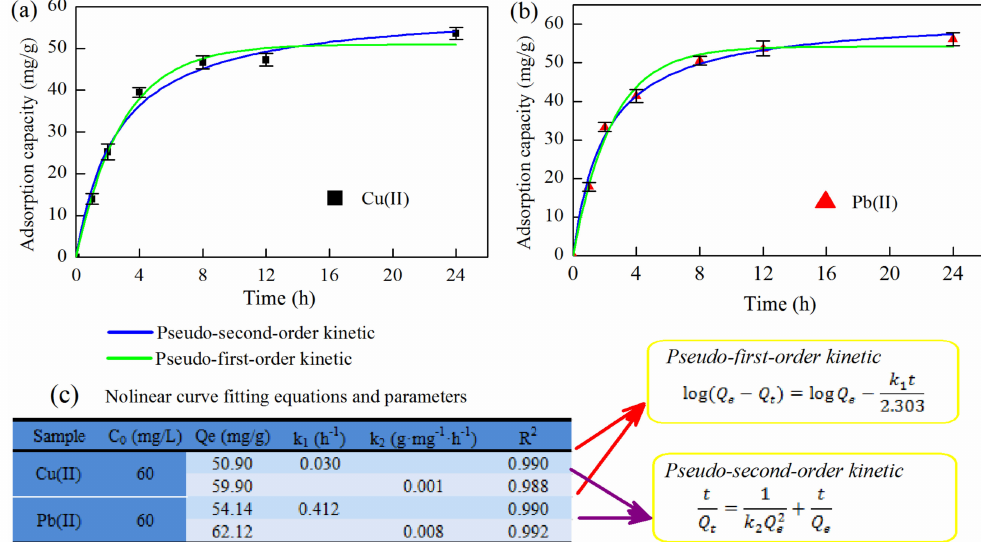
Figure 8. The metal ion, ( a ) Cu(II) and ( b ) Pb(II), adsorption capacity of composite films at different time and kinetics model; ( c ) Fitting parameters of adsorption with kinetic model, t is the adsorption time (h), Q t is the adsorption capacity at t (mg/g), Q e is the equilibrium adsorption capacity (mg/g), and k 1 , k 2 are adsorption rate